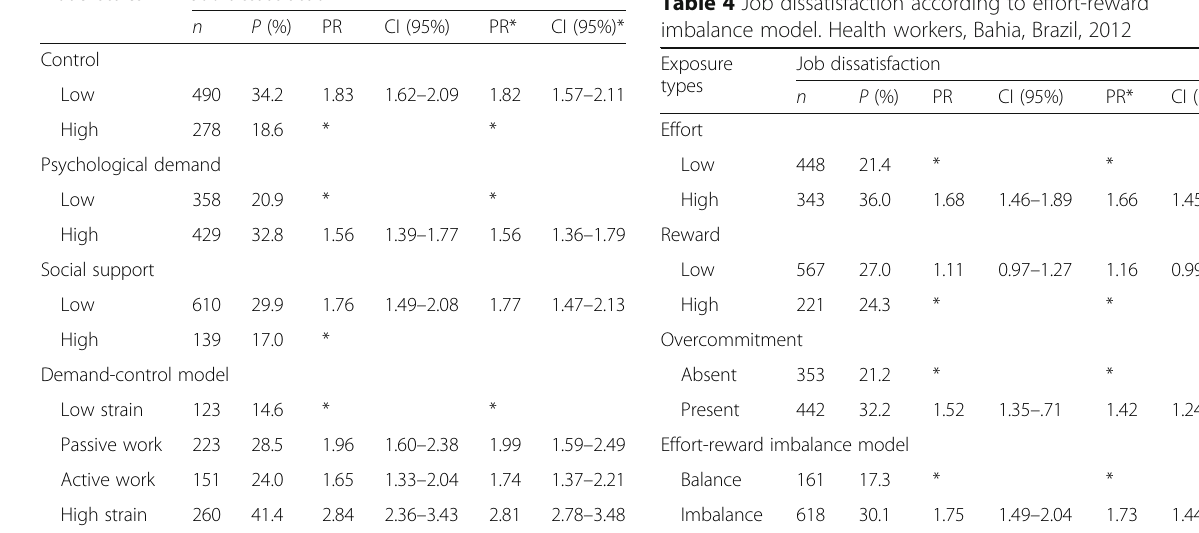
Table 3 Job dissatisfaction according to the demand-control model among health workers, Bahia, Brazil, 2012 Model